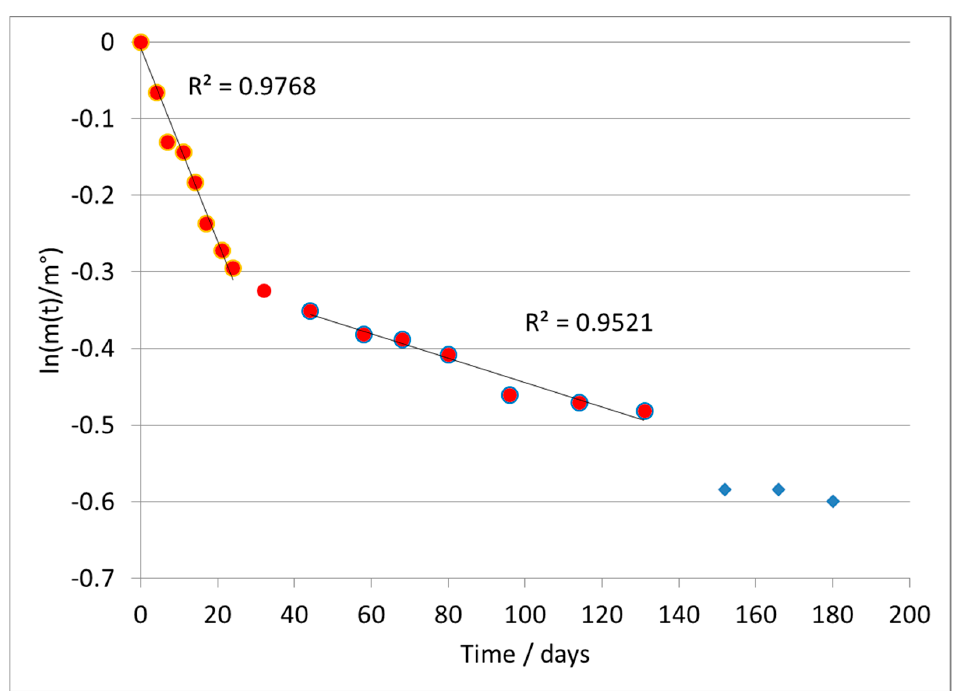
Figure 5. Linear regression of the curve of conversion of material C according to the first-order model. Blue diamonds were considered as outliers and not included in the regression.